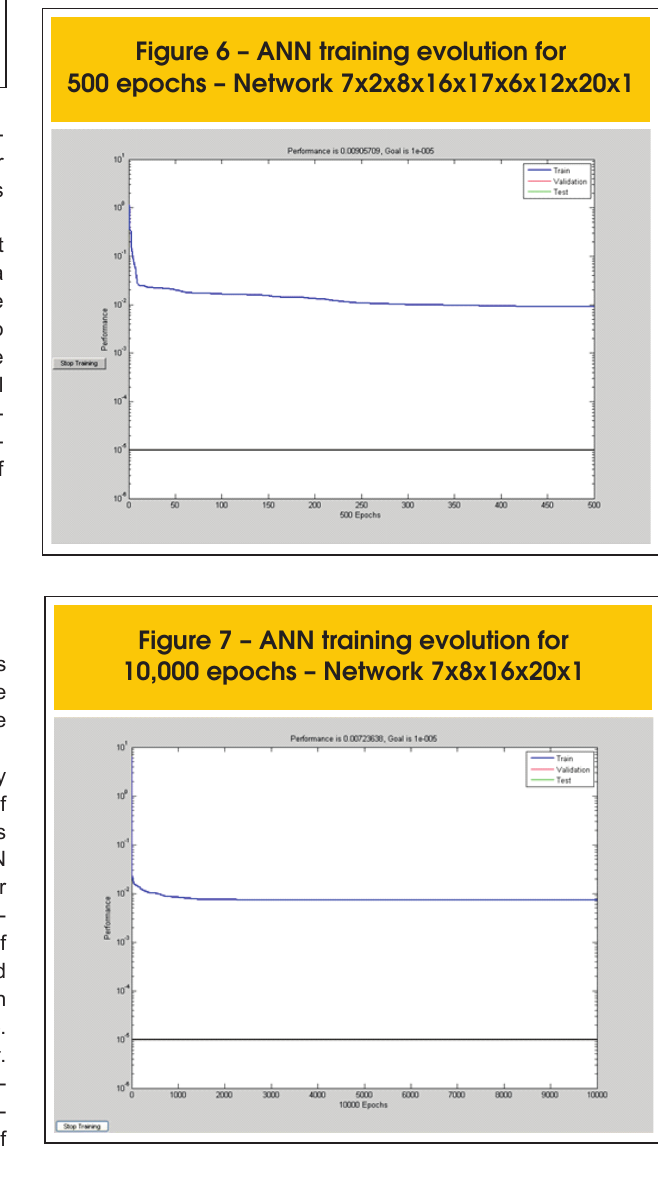
Figure 6 – ANN training evolution for 500 epochs – Network 7x2x8x16x17x6x12x20x1